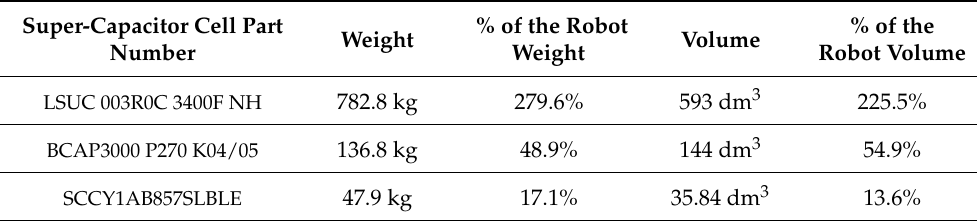
Table 5. Comparison of the weight of the different super-capacitor SESS, considering the weight and volume of the robot (280 kg/262.5 dm 3